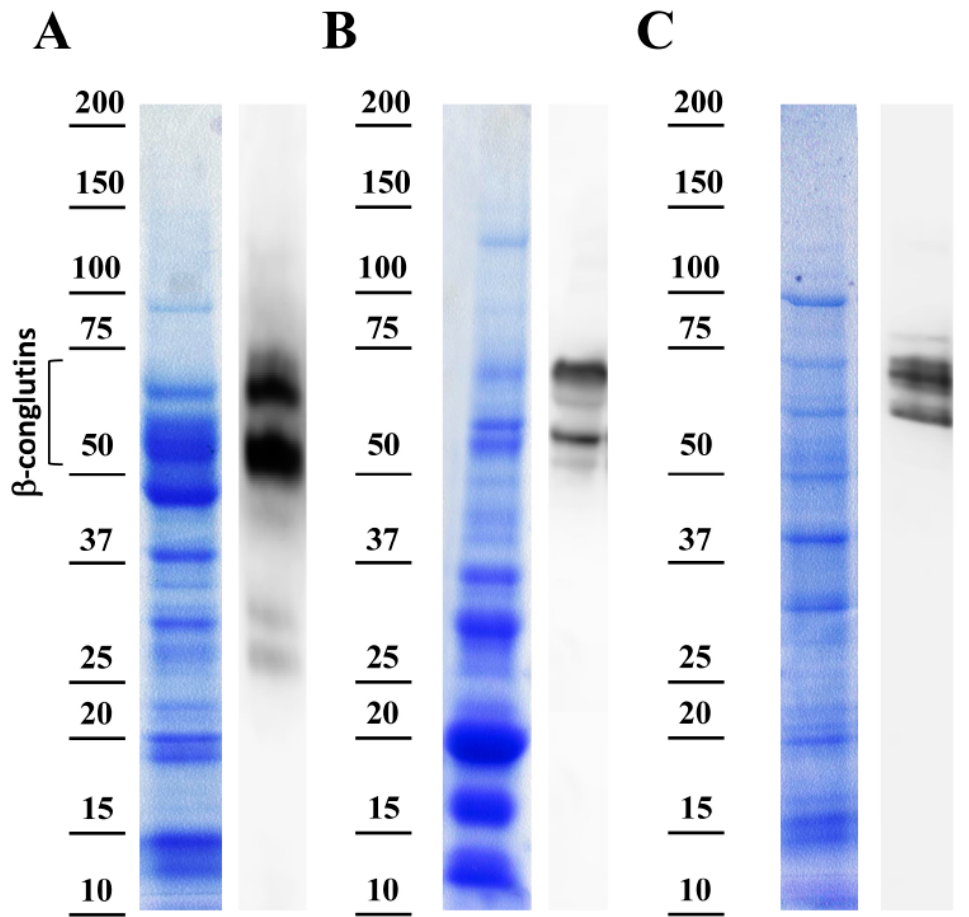
Figure 3. Specificity assessment of anti- β -conglutin antibody. Left panels show the Coomassie-stained SDS-PAGE protein bands from the total protein extracts, and the right panels show immunoblotting with the presence of β -conglutin proteins from ( A ) Lupinus angustifolius , ( B ) Lupins albus , and ( C ) Lupinus lotus .